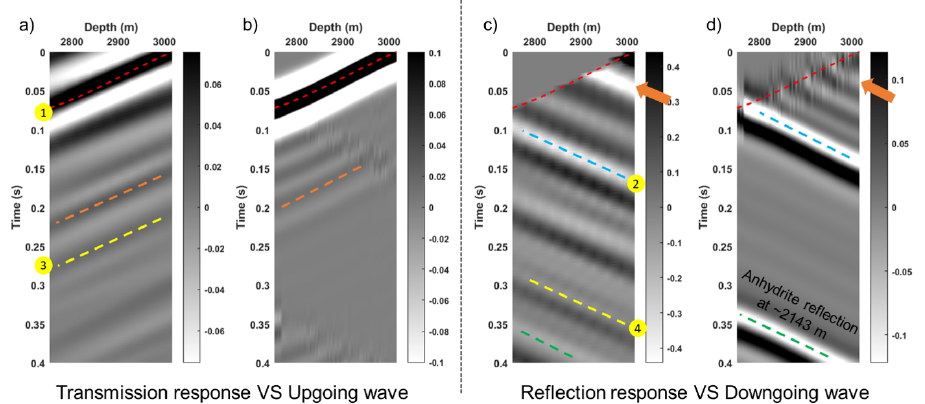
Figure 16. Interferometry using check shot data for a virtual source at the bottom geophone. ( a , b ) show the estimated transmission response and the actual upgoing wave from the model. ( c , d ) show the estimated reflection response and the actual downgoing wave from the model. The up- and downgoing wave synthetic response is generated from the same truncated model as in Figures 11d and 12d, except now using an 18-Hz peak frequency